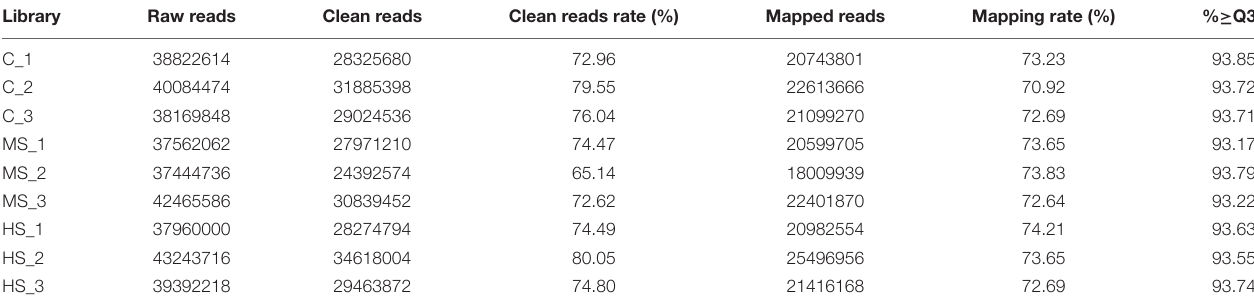
TABLE 1 | The sequence quality and mapping results in the nine